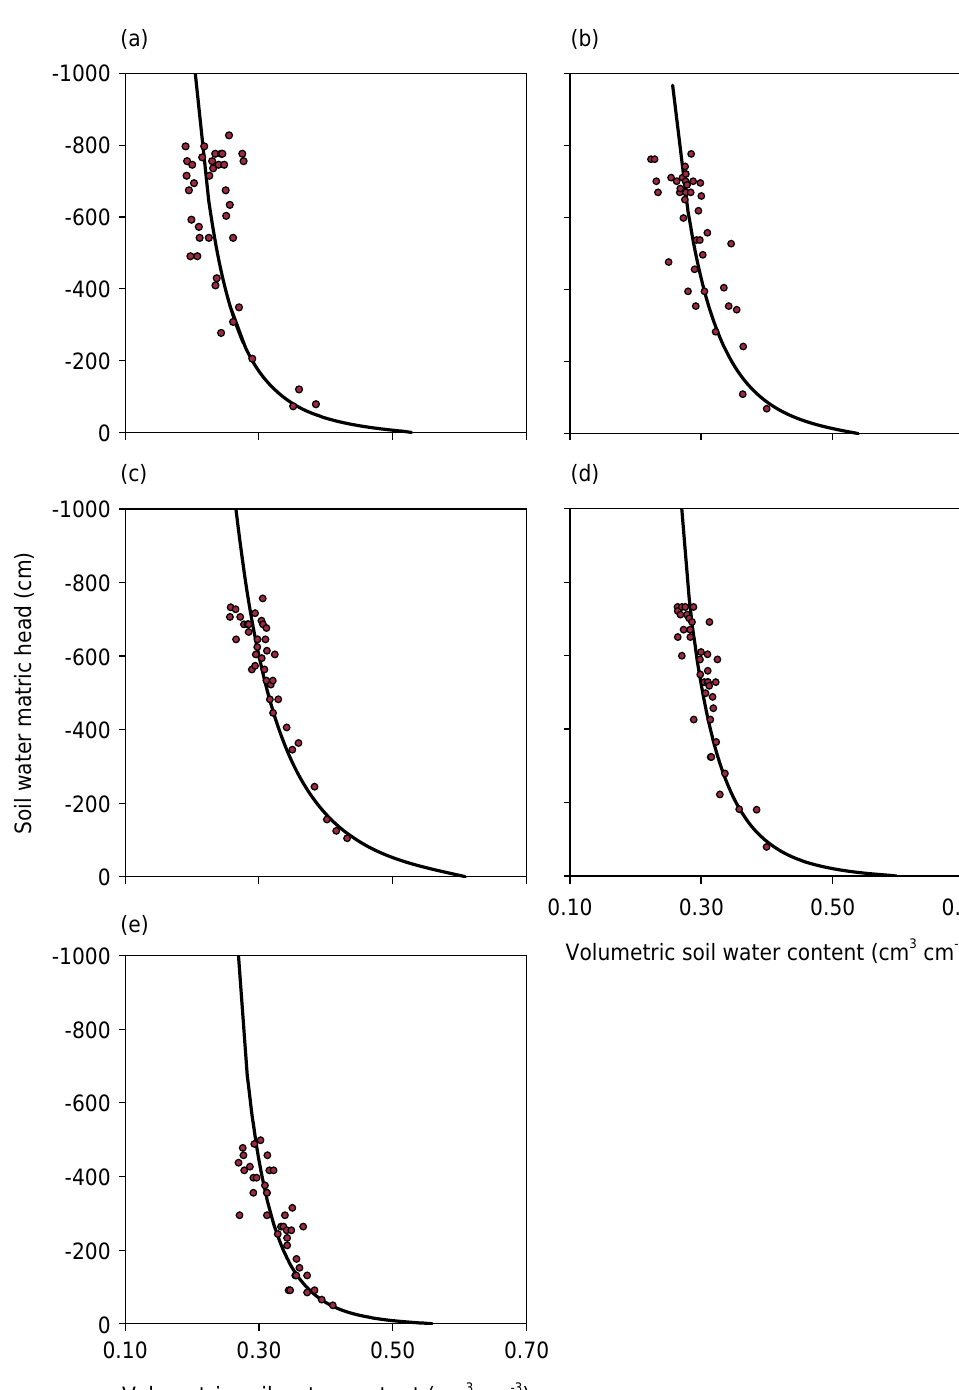
Figure 1. Representation of the h ( θ ) relationships of the soil profile: (a) 0.15 m depth; (b) 0.30 m depth; (c) 0.45 m depth; (d) 0.6 m depth; and (e) 0.9 m